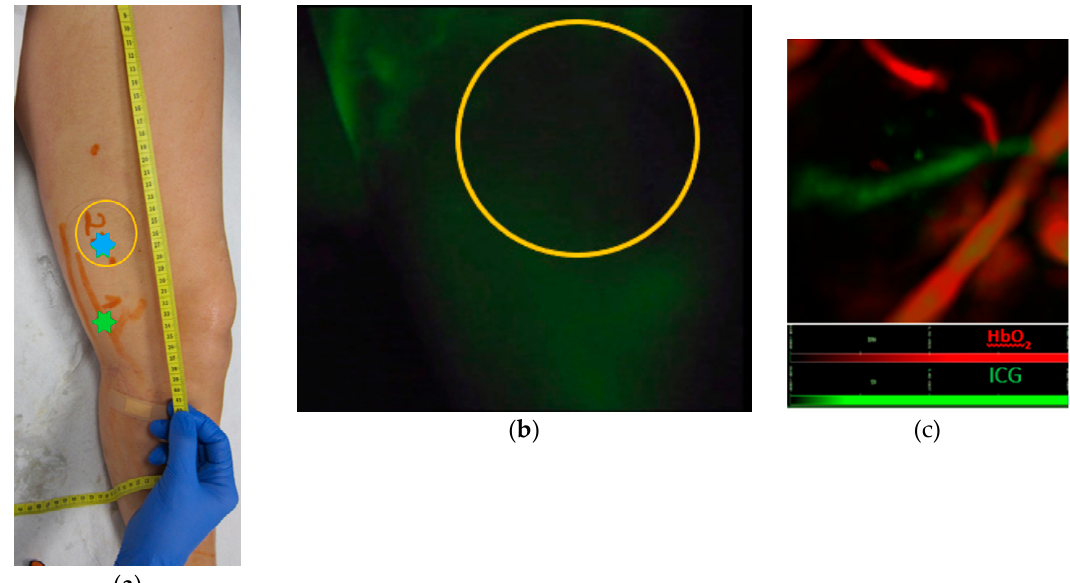
Figure 3. ( a ) Patent lymphatics detected by ICG lymphography are marked on the skin with an orange marker. On the linear pattern, there is a match (green star) between the lymphatic vessel detected by ICG lymphography and MSOT (image not shown). ( b ) In the area proximal to the linear pattern, no fluorescence was visualized (yellow circle) but a lymphatic vessel (blue star) was identified by MSOT. ( c ) MSOT identification of lymphatic vessel (green) and veins (red) in the area of the limb without visible fluorescence, see yellow circle with blue star in ( a ). In patients with primary (Figure 4) and secondary lower limb lymphedema, lymphatic vessels were identified in areas exhibiting a diffuse ICG pattern.